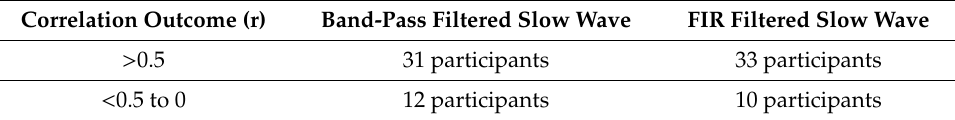
Table 1. Correlation outcome between slow waves of TOF and attenuation